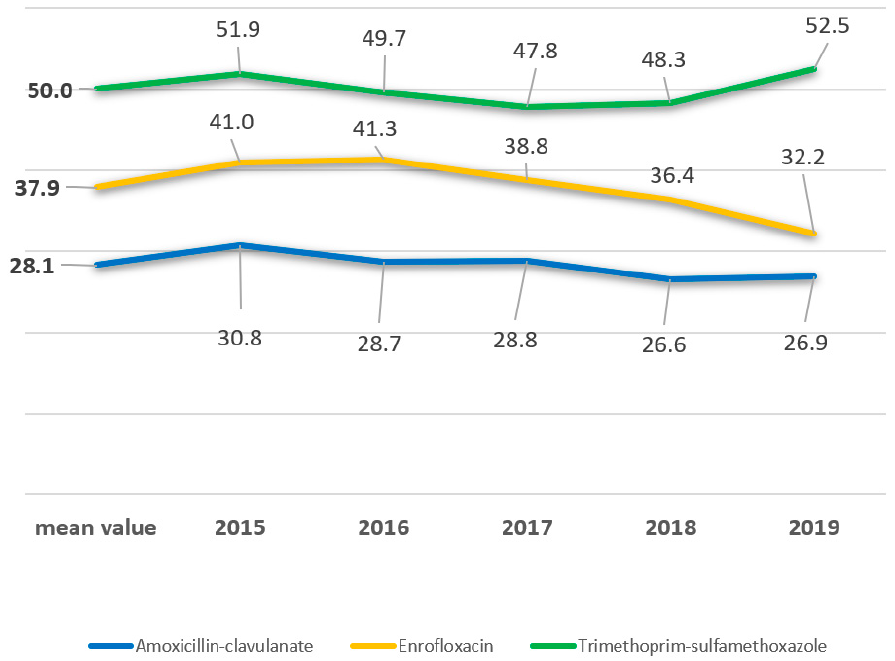
Figure 2. The mean value (bold) and the five-year trend on non-susceptible E. coli isolated from calves revealed the highest proportion of isolates against trimethoprim-sulfamethoxazole, followed by enrofloxacin and amoxicillin-clavulanate. The trends regarding enrofloxacin and amoxicillin-clavulanate remain at a stable level and rather tend towards a decrease regarding the number of non-susceptible isolates. The graph of non-susceptible isolates regarding trimethoprim-sulfamethoxazole reveals a decrease, 2016–2017, followed by a steep increase of non-susceptible isolates in 2019. The corresponding statistic parameters are presented in Table 1. Table 1. Statistic parameters regarding the increase or decrease of resistance values within the five ‐ year period for the three clinically relevant antimicrobials (Figure 2).